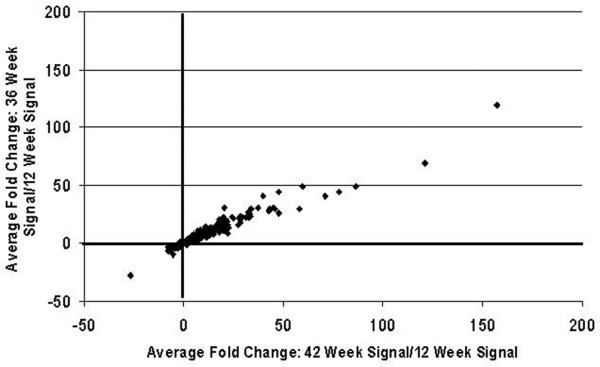
Close similarities in disease-related gene expression changes in kidneys at 36 and 42 weeks of age. Between the 42-week diseased group and the asymptomatic group with false discovery rate (FDR) p < 0.05 and average fold change more than 1.5, 1141 probe sets were identified to be differentially expressed. Average fold changes of these 1141 probe sets for the 42-week comparison with the asymptomatic group are shown on the X axis. The average fold changes for the 36-week comparison with the asymptomatic group are on the Y axis. Note, that although the magnitude of the changes at 42 weeks tended to be slightly larger than those at 36 weeks, the direction of change of all 1141 probe sets was the same and the magnitude of the changes are very well correlated (Pearson correlation = 0.97). The criteria used to identify 1141 probe sets are more relaxed than those used to identify lupus nephritis genes. This was to show that even the smaller changes (1.5 versus twofold change) observed in this model are well correlated at 36 weeks and 42 weeks.